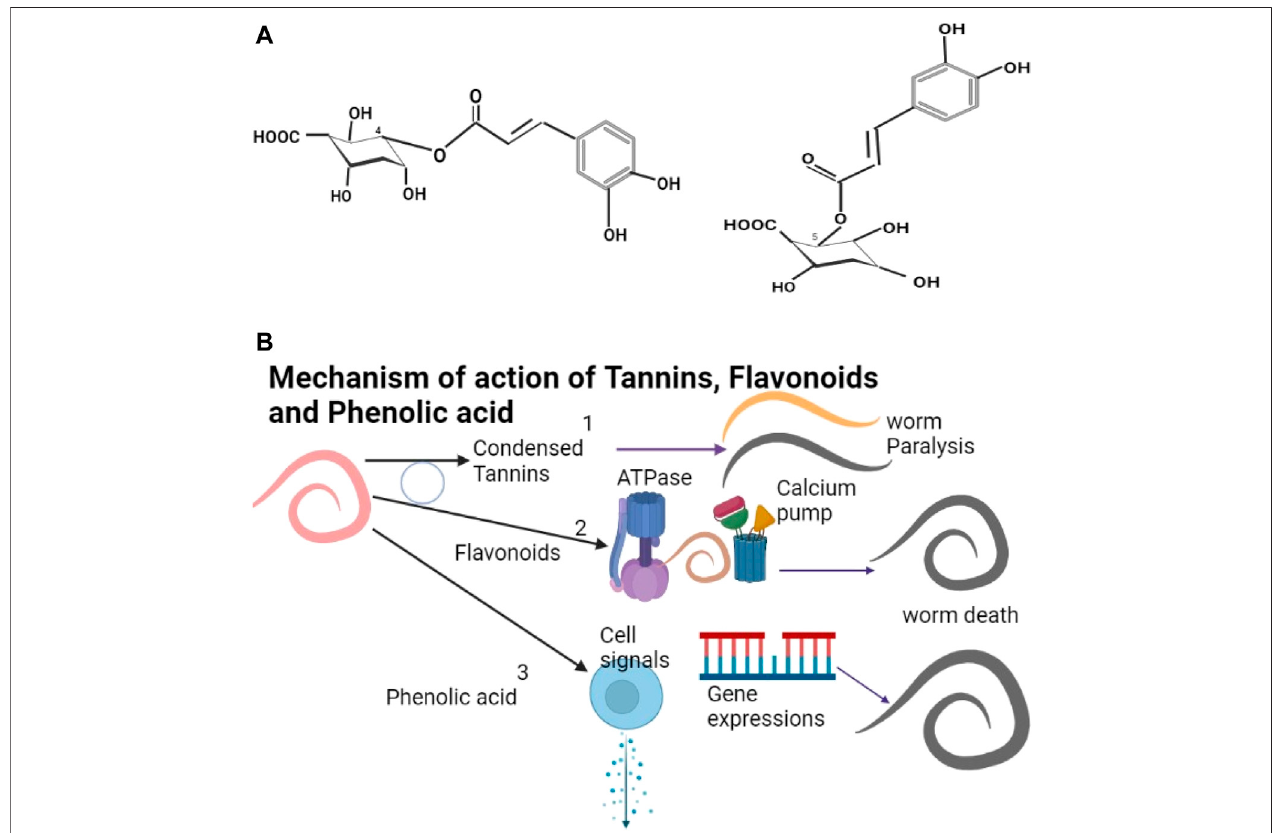
FIGURE 1 | (A) 4-O-Caffeoylquinic acid and 5-O-caffeoylquinic acids are examples of phenolic acids in green coffee beans (Wei and Tanokura, 2015). (B) (1) Condensed Tannins cause paralysis and death of helminths. (2) Flavonoids affect the calcium pump and ATPase leading to the death of the helminth. (3) Phenolic acids affectcellsignalingpathwaysandgeneexpressionsleadingtothedeathofthehelminth.ThebluecircleshowspossiblesynergisticactionsbetweenCondensedTannins and